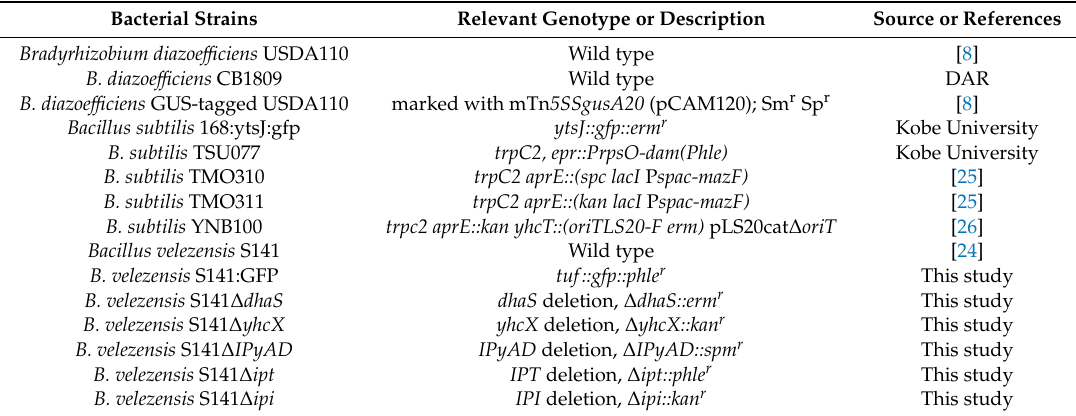
Table 1. Bacterial strains used in this